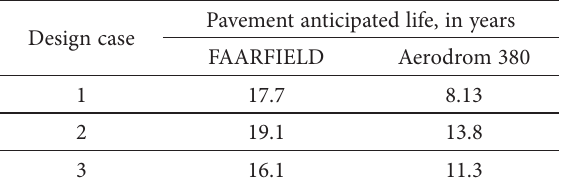
Table 4. Pavement anticipated life Design